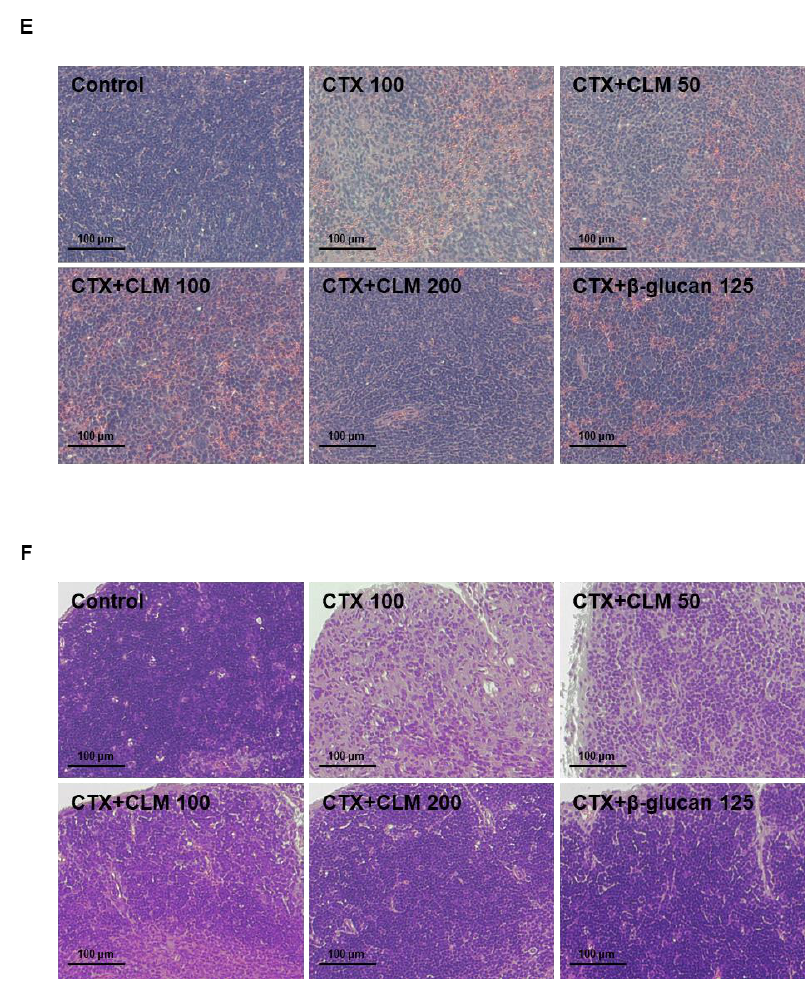
Figure 1. Influence of C . lacerata mycelia (CLM) on body weight, spleen index, and thymus index in cyclophosphamide (CTX)-treated mice. ( A ) General schematic diagram of the immunosuppression model and CLM treatment. Effect of orally administered CLM on body weight ( B ), spleen index ( C ), and thymus index ( D ) in CTX-immunosuppressed mice. CLM (50, 100, and 200 mg/kg/day) suspended in saline was administered orally once daily for 14 days. Mice were treated on days 7 – 9 by intraperitoneal injection of CTX (100 mg/kg/day) in a total volume of 100 µL of saline. The control group was treated with vehicle alone. The immune organ index (%) was calculated as follows: index = organ weight (mg)/body weight (g). The thymus and spleen were obtained on day 15 and weighed. Spleen ( E ) and thymus ( F ) tissues in the HE-stained histopathological images (total magnification 100×). Data are expressed as mean ± SD ( n = 6). * p < 0.05 vs. normal group; # p < 0.05 vs. CTX-treated group.